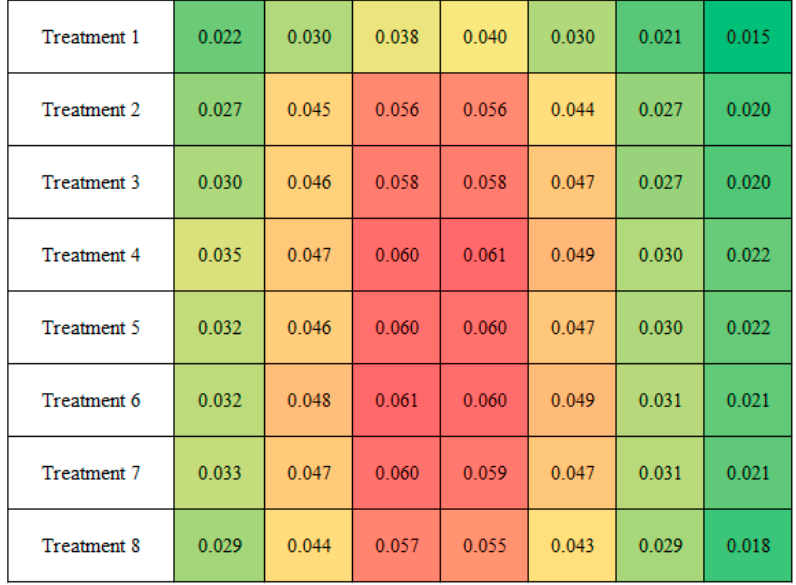
Figure A6. Map of UV light intensity (irradiance) measurements for UV ‐ C (222 nm) for Treatment 1 to Treatment 8. The color gradient green–yellow–red represents increasing UV light intensity. Units: mW/cm 2 .